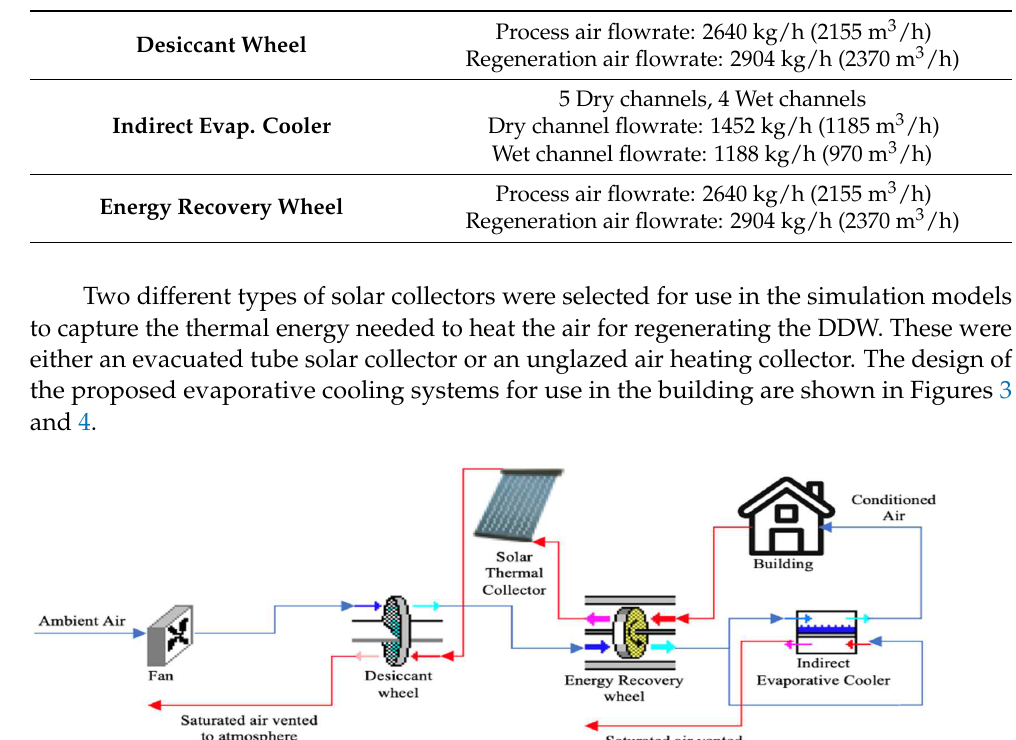
Figure 4. Proposed system using ambient air to regenerate the desiccant wheel. The surface area necessary for the solar thermal collector to heat the air required to regenerate the DDW differed significantly, as the evacuated tube solar collector required significantly less area than that of the unglazed air heating collector to provide the thermal energy necessary to heat the regenerative air for the DDW. The surface area required by the evacuated tube solar collector for the proposed system using conditioned air from the building to maintain the temperature within the building at 18–26 °C is only approxi- mately 40 m 2 . The unglazed air heating collector requires a surface area of approximately 115 m 2 to achieve room temperatures that are similar to those achieved using an evacuated tube solar collector. The simulation models developed using TRNSYS were run over an eight-month pe- riod during the hottest period experienced in Kuwait, from April 1 (2160 h) to 30 Novem- ber (8016 h); weather data from Kuwait was used to simulate atmospheric conditions that a building would experience. A commercial building design was used in the model (Fig- ure 5) that has all the internal and external walls, ceiling and roof thermally insulated. The building covers an area of approximately 300 m 2 , and the proposed cooling system oper- ates from 8 am to 5 pm to better determine how the system performs in a commercial building during normal business hours when the building is occupied. The model is set up in such a way that the system switches on when the temperature is more than 26 °C.